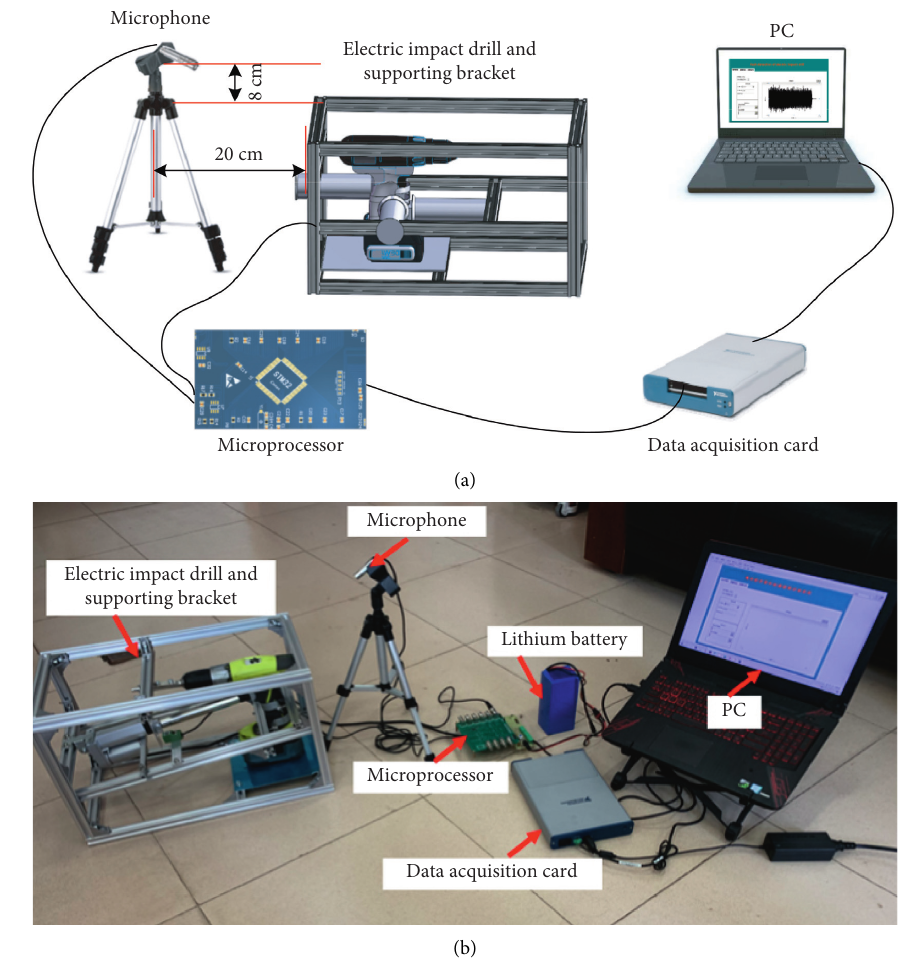
Figure 5: (a) Schematic diagram of the experimental setup and (b) experimental setup of the electric impact